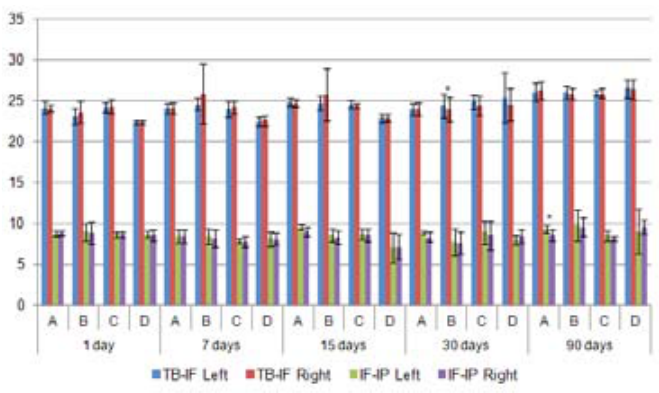
FIGURE 3 - Mean values and standard deviations (SD) of the cephalometric mensurations (mm) of the skull of all the groups according to the experimental period. A=Control, B=DEX, C=MTX Low dose, D=MTX High dose. (*) Statistical difference between right and left sides.